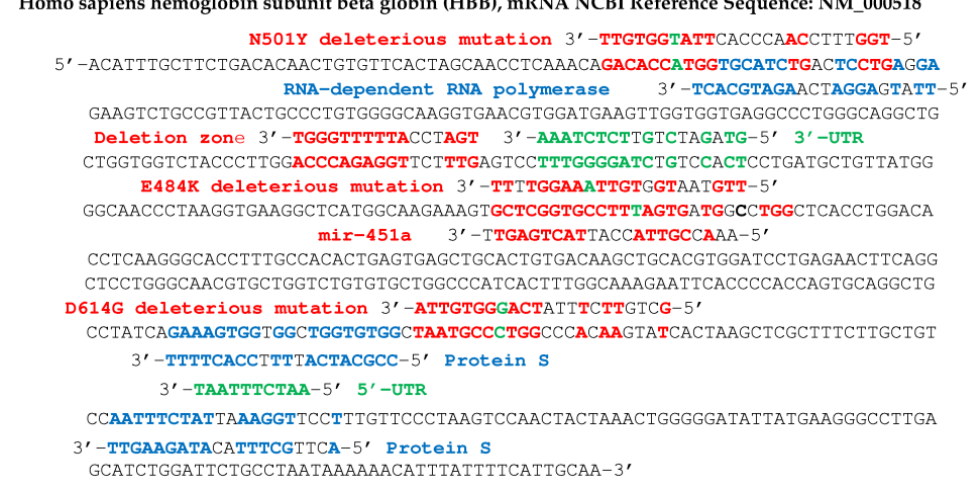
Figure 6. Human fetal hemoglobin gamma 2 subunit (HBG2) gene. Sequences in blue (resp. red) come from ORF10 and protein S genes and from the deletion zone of SARS-CoV-2 (resp. from hsa miR 129-5p). Probability of length 8 hybridization by chance in red (resp. 9, 11 in blue) for 577 nucleotides is equal to 0.035 (resp. 0.017, 0.0003), T-G and G-T hybridizations counting for ½ .